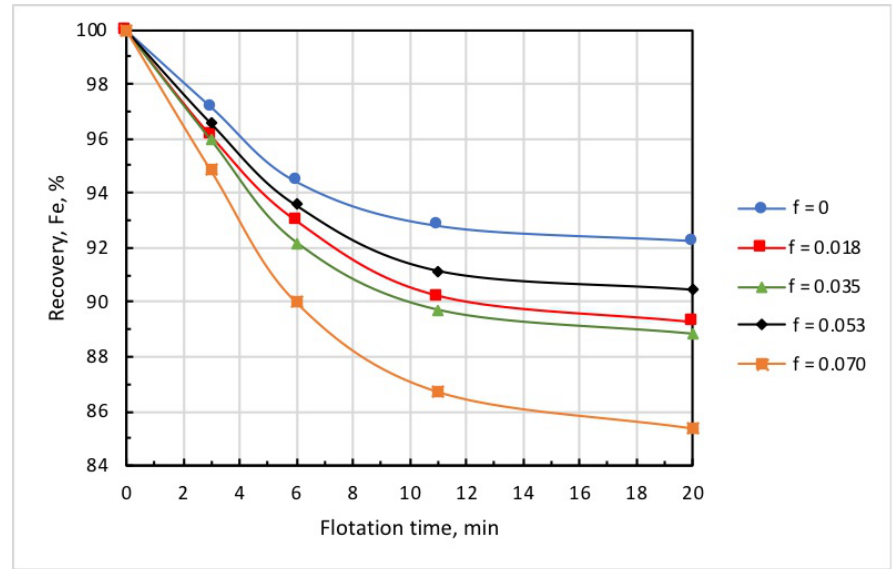
Figure 8. Kinetics of iron recovery at different doses of microbubbles f (mL/g) introduced before flotation start: collector dose, 20 g/t; airflow rate, 0.18 L/min.